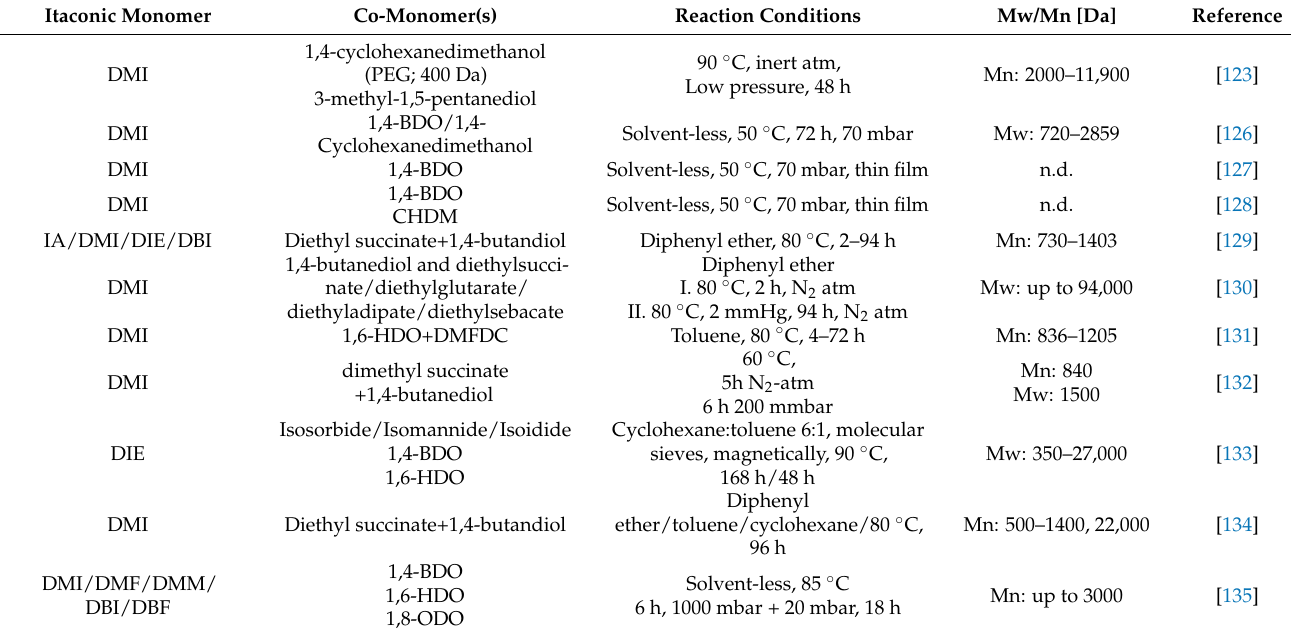
Figure 4. Polymerization possibilities of itaconic acid derivatives. Table 4. Lipase-catalyzed synthesis of itaconic acid